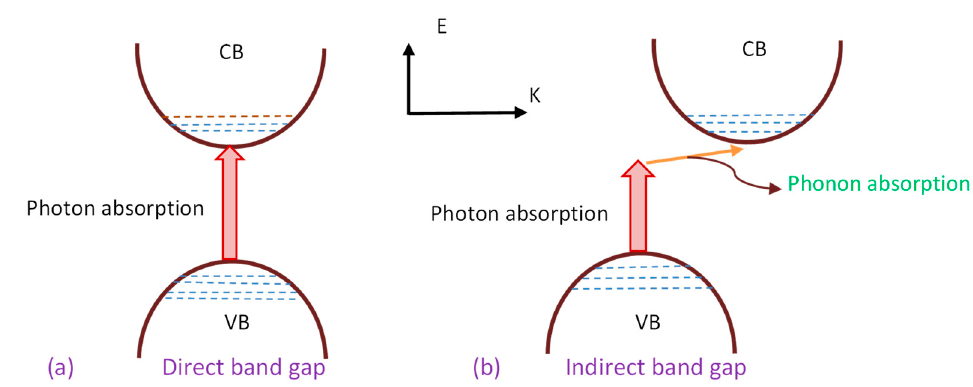
Figure 14. Electronic transition with ( a ) direct allowed transition and ( b ) direct forbidden transition.